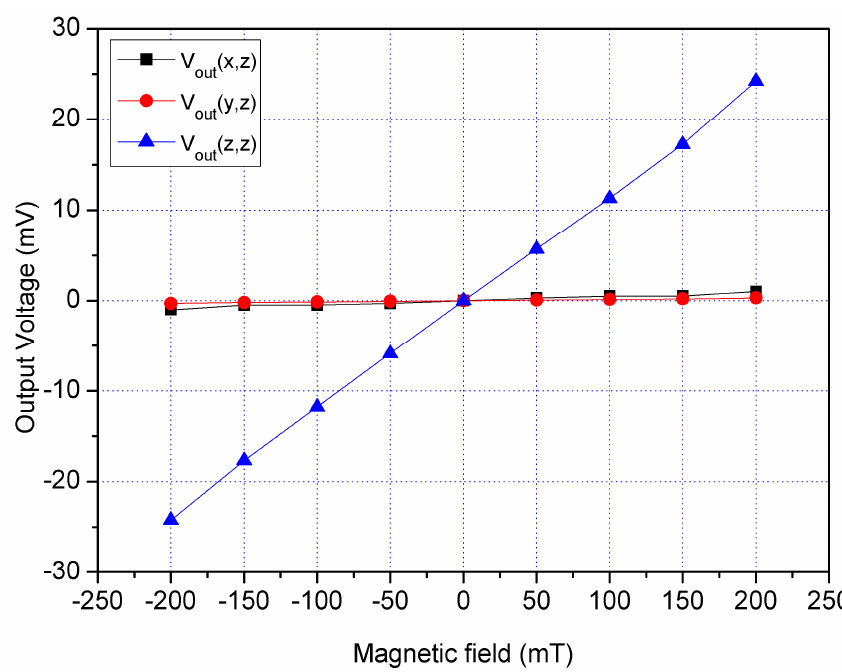
Figure 20. Measured Vo for the MS in the z-direction MF.